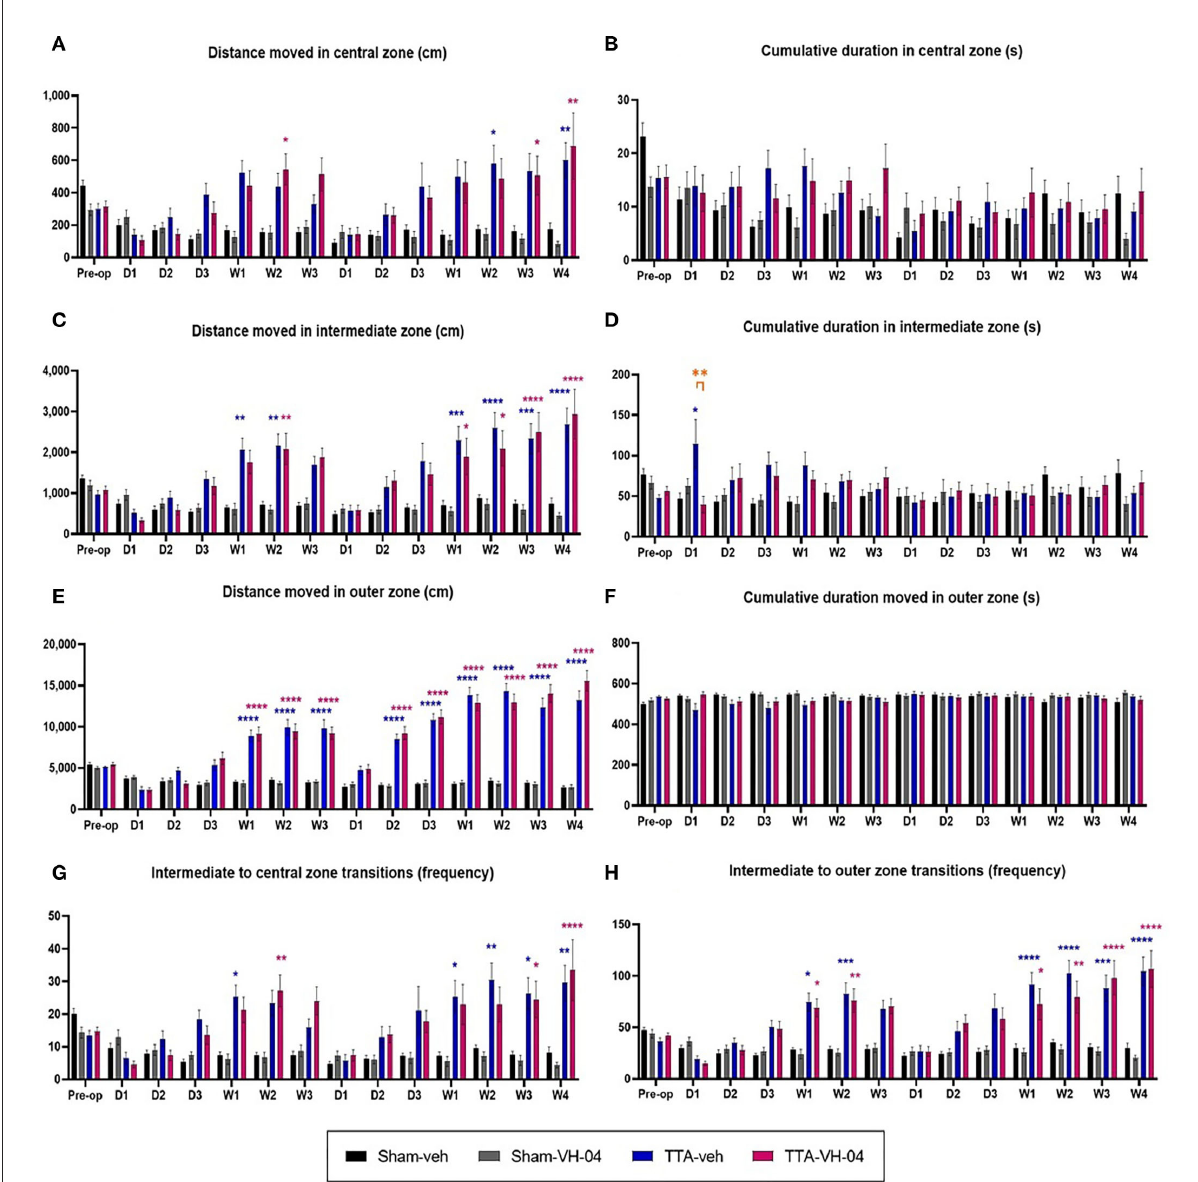
FIGURE7 Effect of Vertigoheel on thigmotaxis automatically measured in a 10 min-session in an open field. Illustration of the distance moved (A) and the cumulative duration (B) in the central zone. Illustration of the distance moved (C) and the cumulative duration (D) in the intermediate zone. Illustration of the distance moved (E) and the cumulative duration (F) in the outer zone. Illustration of the number of transitions from intermediate to central (G) and intermediate to outer (H) zones. Data represent mean ± SEM. Three-way ANOVA applies to all graphs. Significant differences between Sham-VH-04 and TTA-VH-04, Sham-veh and TTA-veh, and TTA-VH-04 and TTA-veh are indicated by purple, blue, and orange stars, respectively. * p < 0.05; ** p < 0.01; *** p < 0.001; **** p < 0.0001. Sham-veh and Sham VH-04, n = 16; TTA-veh and TTA-VH-04, n =